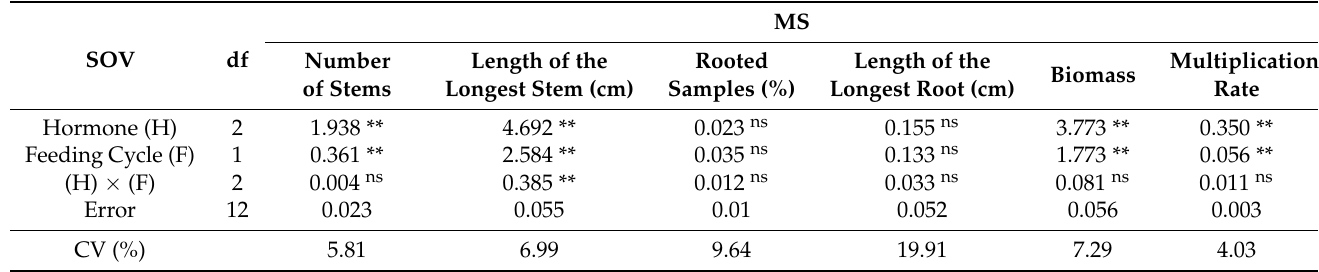
Table 6. Analysis of variance comparing micropropagation in a solid culture medium with micro- propagation in a temporary immersion bioreactor system on the growth characteristics of S. pennata seedlings.